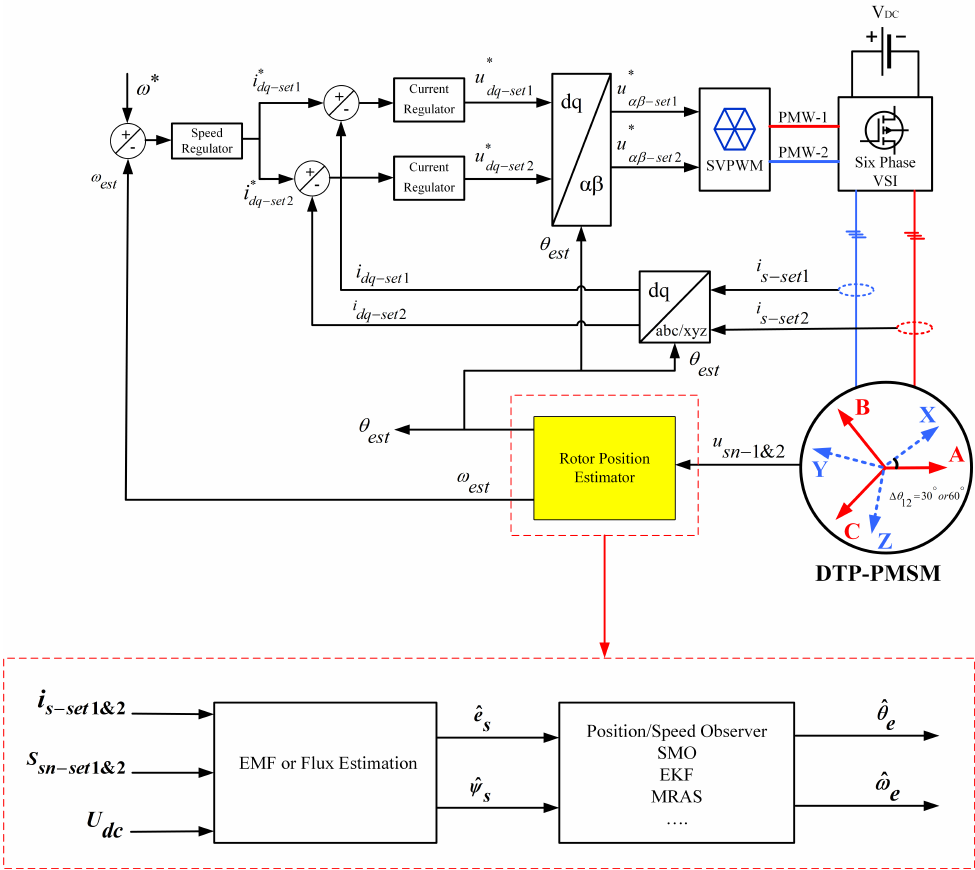
Figure 4. Block diagram of all methods for the control and estimation of position and